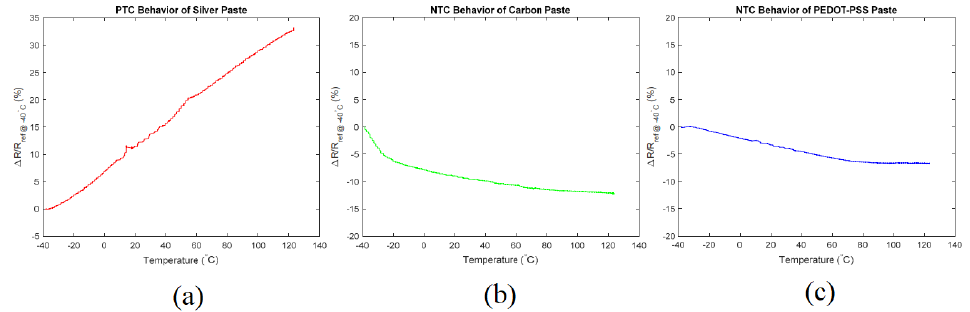
Figure 4. ( a ) Highly linear PTC behavior of silver throughout the test temperature range; ( b ) NTC behavior of carbon; ( c ) NTC behavior of PEDOT:PSS. Note that carbon exhibits near linear NTC behavior after an initial region of non-linear behavior (roughly from − 40 ◦ C to − 20 ◦ C). On the other hand, PEDOT:PSS behaves near linearly initially from around − 40 ◦ C to 70 ◦ C. (Reprinted with permission from [50]. Copyright 2020